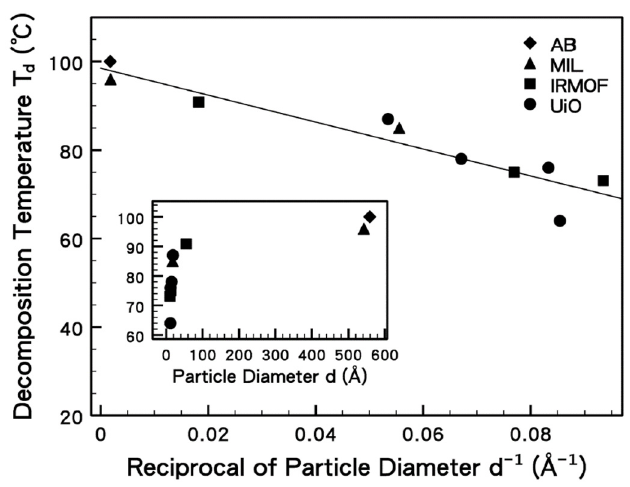
Figure 16. Peaked temperatures (T d ) of the decomposition of neat AB ( ♦ ), and AB confined in MOF of MIL, IRMOF and UiO MOF vs. the reciprocal particle size (d) of the corresponding hydrides. T d vs. d is shown in the inset. Reprinted with permission from [287]. Copyright (2017), American Chemical Society.